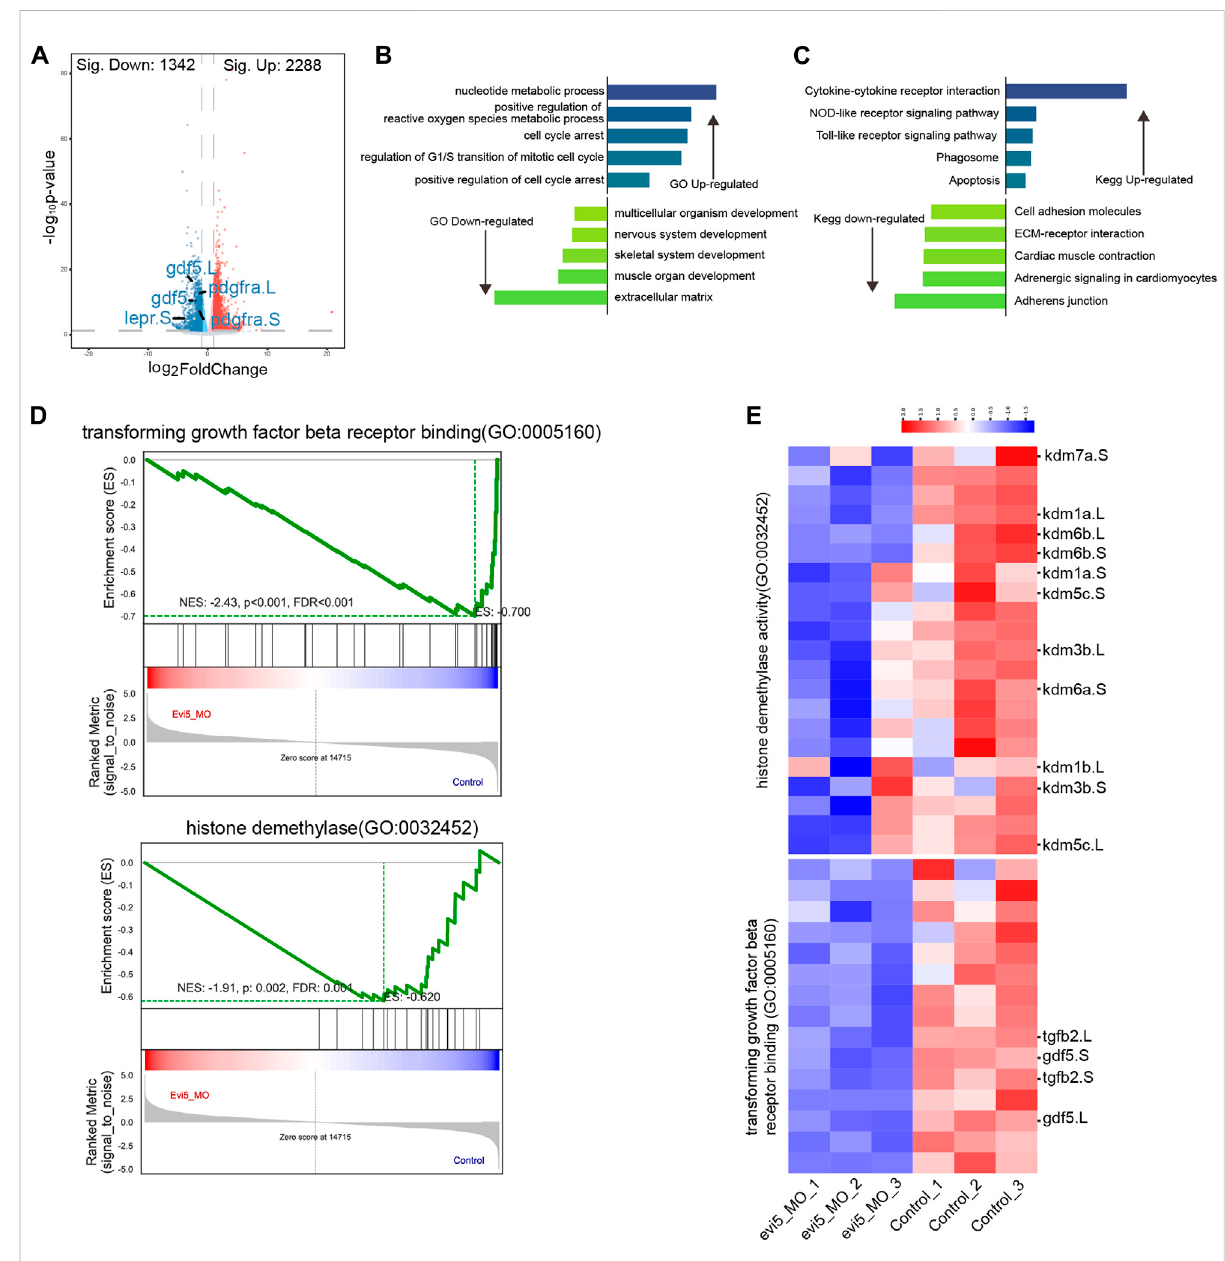
FIGURE 6 RNA-seq analysis of evi5 Mo-injected Xenopus tadpole limbs at 3 dpa. (A) Volcano plot showing differential genes after Evi5 knockdown, with signi fi cant down-regulation markers in blue, signi fi cant up-regulation markers in red, and no signi fi cant difference markers in gray (B) GO enrichment analysis of the biological processes enriched by up- and down-regulated genes, histogram representation - Log10 ( p value). (C) KEGG pathwayenrichmentanalysisofpathwaysenrichedbyup-anddown-regulatedgenes,histogramrepresentation-Log10( p value). (D)